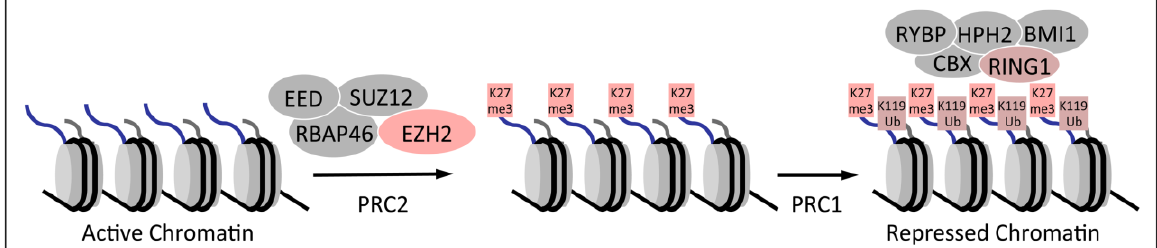
Figure 2. Polycomb mediated silencing of gene expression. The polycomb repressive complex 2 (PRC2) silences chromatin by trimethylating lysine residue 27 (K27me3)